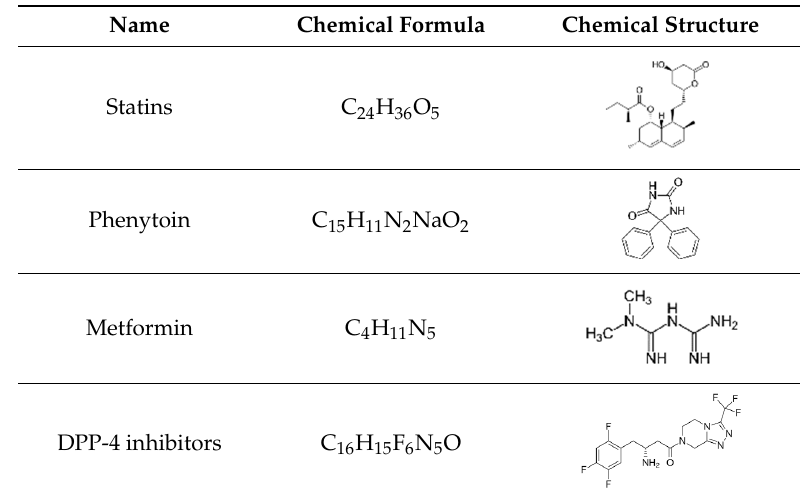
Table 1. Chemical formulas and structures of the four classes of drugs analyzed here, that display good efficacy in the treatment of impaired wound healing.